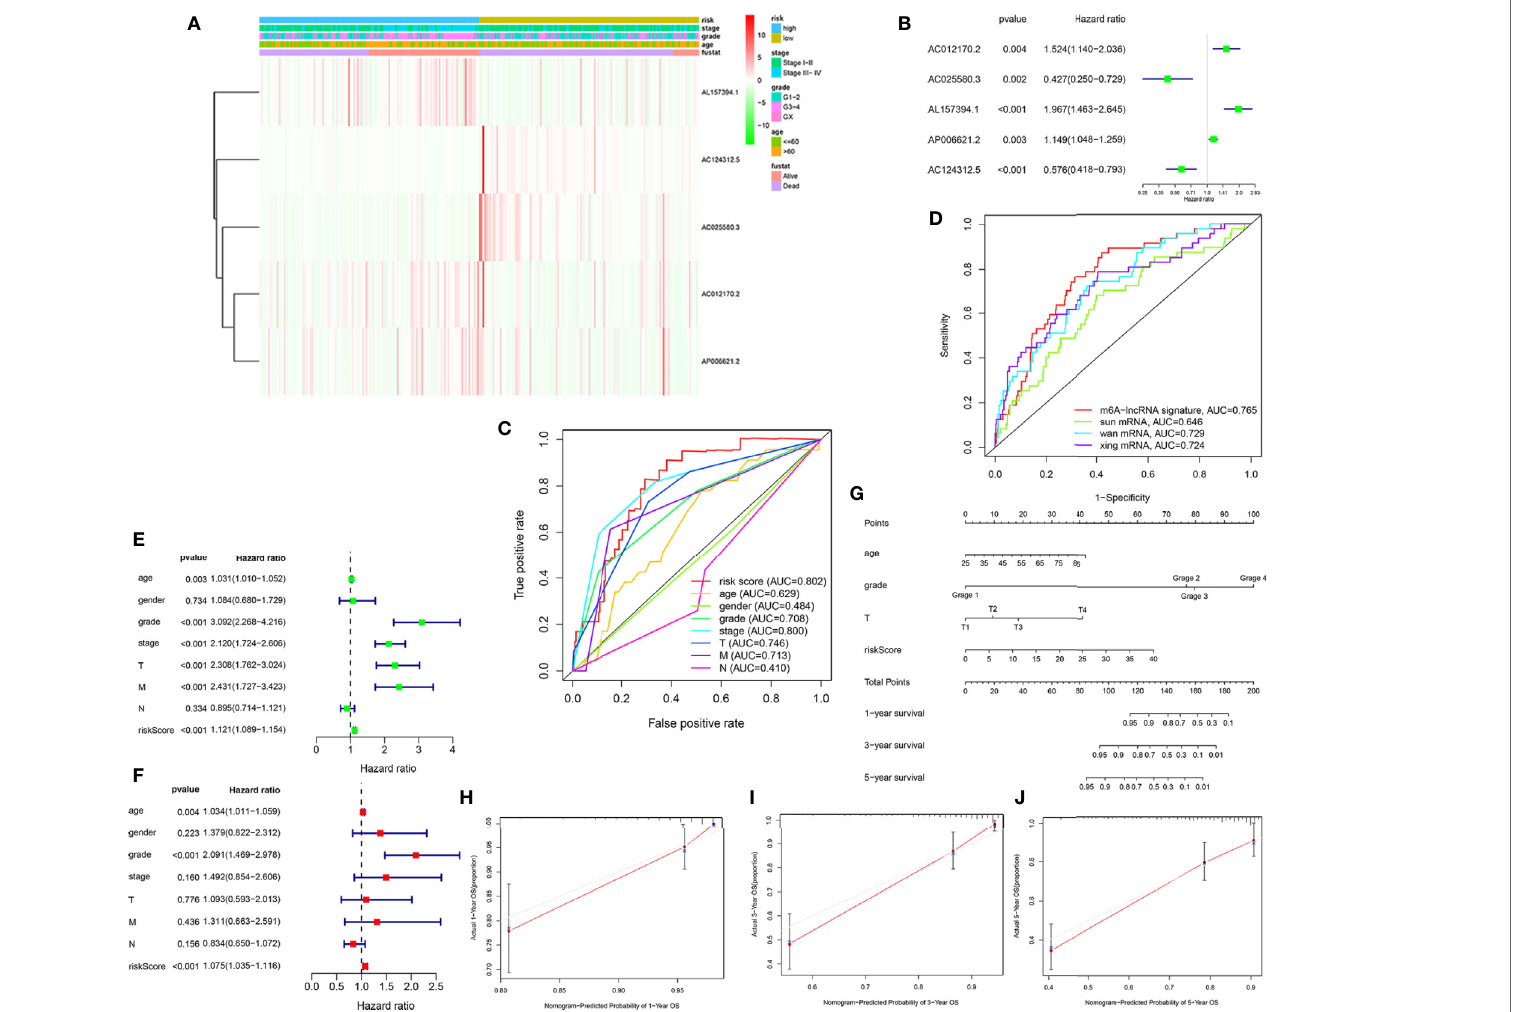
FIGURE 4 | Estimation of clinical Value of the m6A-related lncRNAs prognostic risk signature in KIRC patients. (A) The heatmap showed associations between the expression of the fi ve m6A-related lncRNAs in the low- and high-risk group and clinicopathological features, including survival status (alive or dead), age (>60 y or <=60 y), AJCC stages (stages I – II or III – IV), and AJCC grade (1 – 2, 3 – 4, or NA) (all p < 0.05) in training set. (B) The forest plots showed the prognostic ability of the fi ve m6A-related lncRNAs in the prognostic risk model (p < 0.05). (C) The multivariate receiver operating characteristic (ROC) curve showed predictive accuracy of risk score was higher than other clinicopathological features. (D) Multivariate ROC curves showed the sensitivity and speci fi city of the prognostic risk signature were higher than other published biomarkers in predicting the prognosis of KIRC patients. (E) The univariate Cox regression analysis showed that risk score and clinicopathological features, included age, grade, AJCC stage, T and M stage were prognostic-related variables. (F) The multivariate Cox regression analysis showed risk score, grade, age were independent prognostic factors. (G) Construction of a prognostic nomogram based on risk score and prognostic-related clinicopathological parameters to predict 1-, 3-, 5-year overall survival of KIRC patients. (H – J) The calibration curves of the nomogram displayed the concordance between predicted and observed 1-, 3-, and 5-year